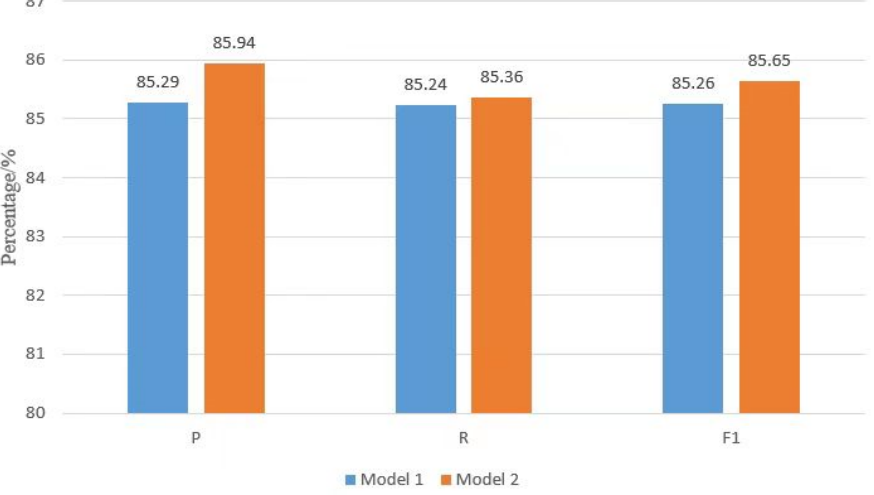
Figure 4. The performance statistics of the semi-supervised learning